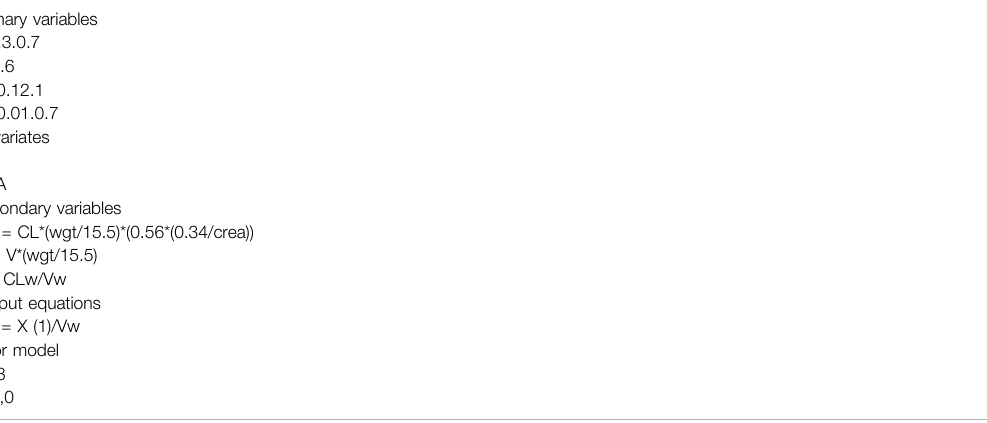
TABLE 4 | Pmetrics model for the fi nal covariate model for vancomycin. #Primary variables CL,0.3.0.7